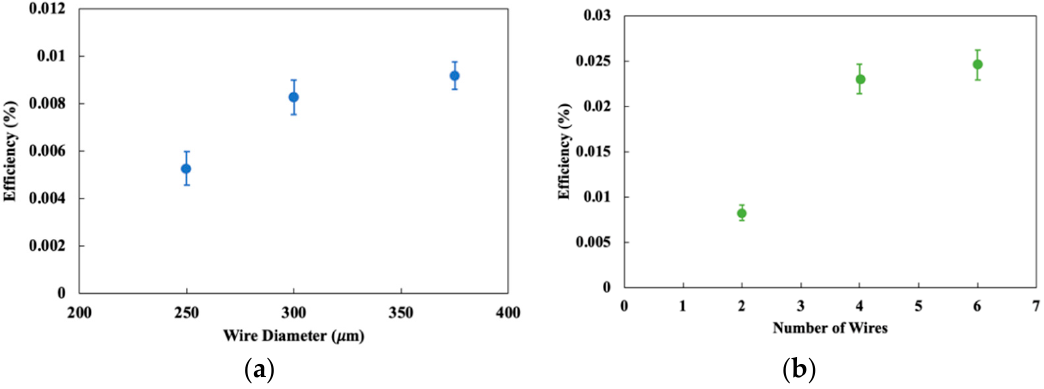
Figure 11. Efficiency test results. ( a ) Efficiency test results for varying wire diameters in a 2-wire configuration; ( b ) efficiency test results for varying numbers of wires with 300 μ m diameters.